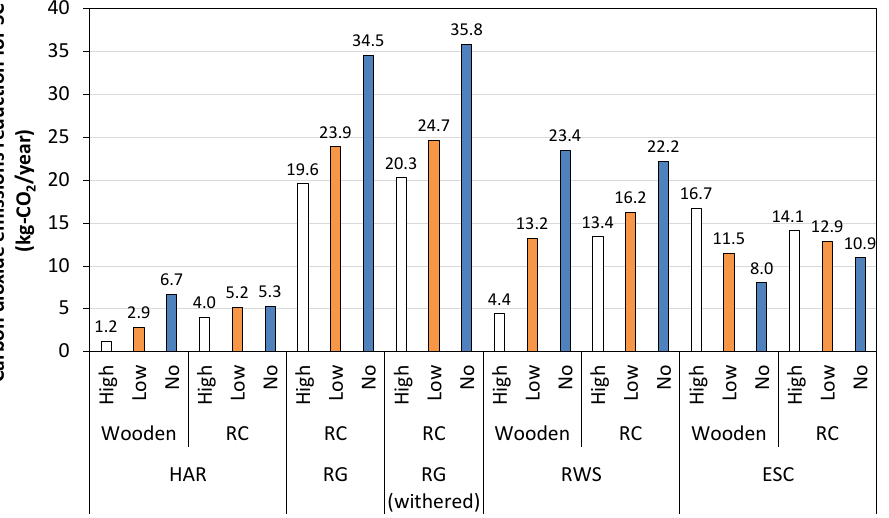
Figure 13. Annual reduction of CO 2 emissions from space conditioning by applying the UHIE countermeasures.